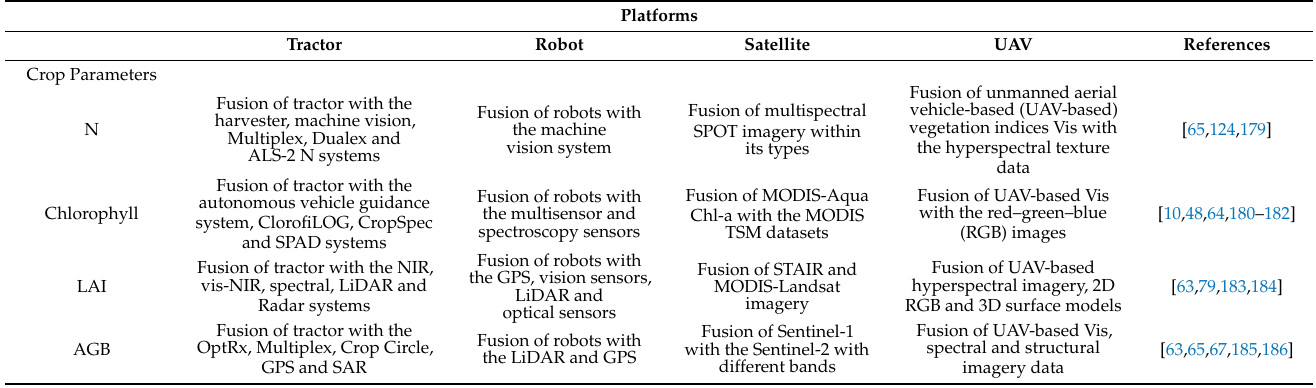
Table 2. Ground, space-borne and aerial platforms fusion methods for crop parameter estimation.